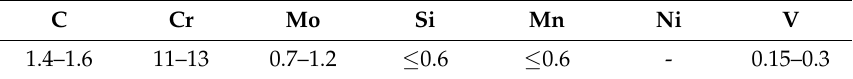
Table 2. Chemical compositions of SKD11 tool steel (%) [34].